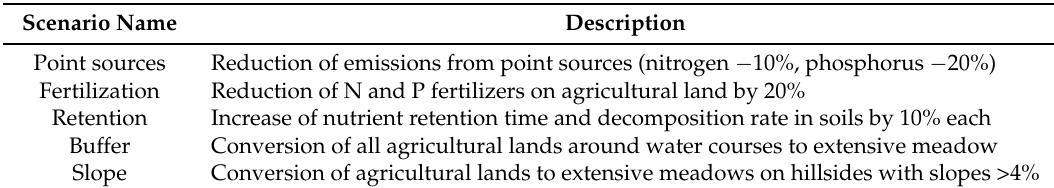
Table 5. Description of applied land use change experiments in the Elbe river